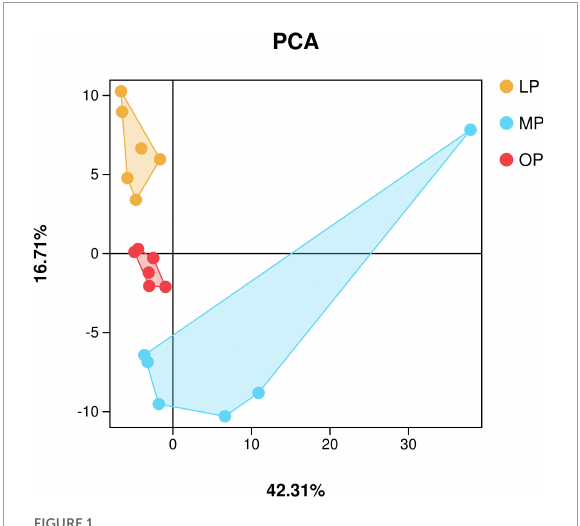
FIGURE1 Principal component analysis